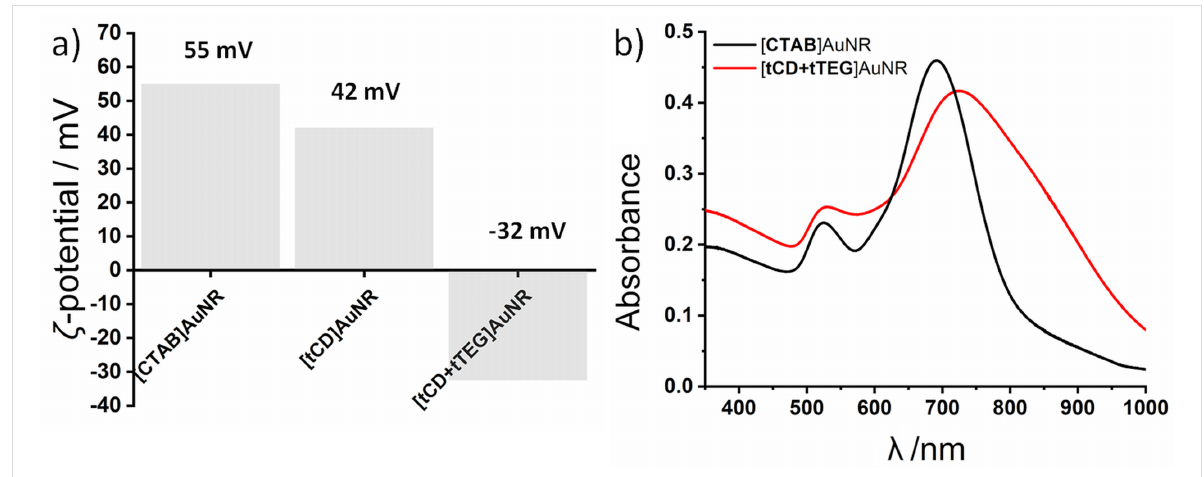
Figure 1: a) ζ -Potential measurement of different stages of the ligand exchange. b) UV–vis spectroscopy before (black) and after complete ligand exchange